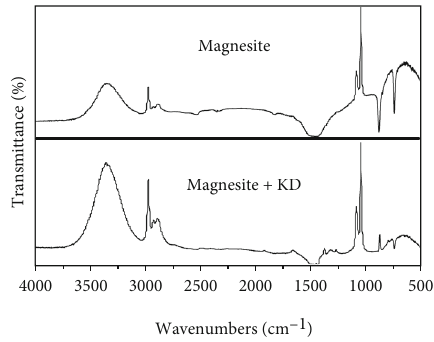
Figure 18: FTIR spectra of magnesite and